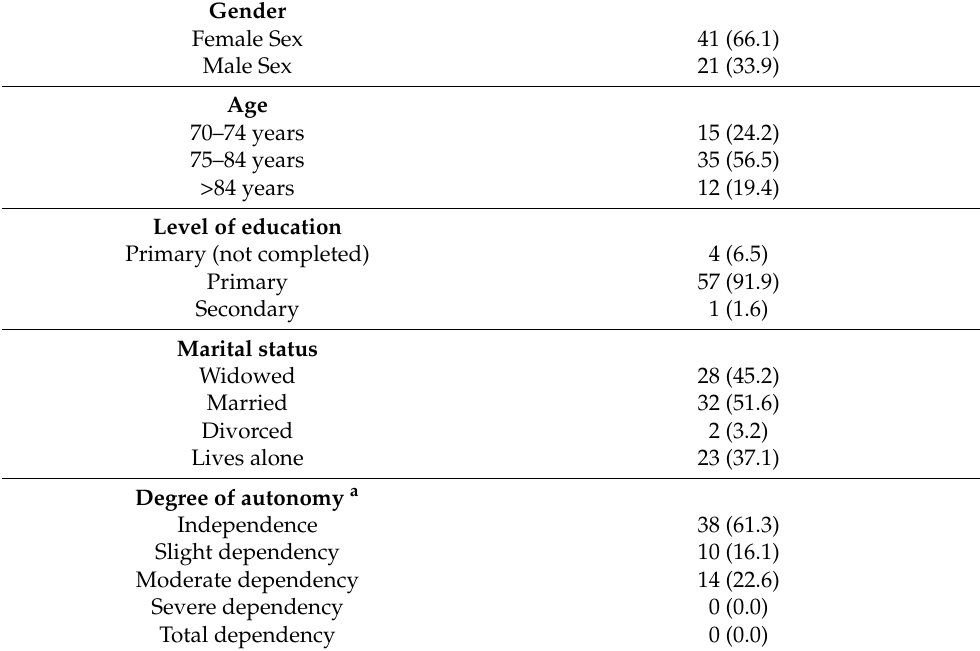
Table 1. Socio-demographic and clinical characteristics of study participants, n (%) . n =